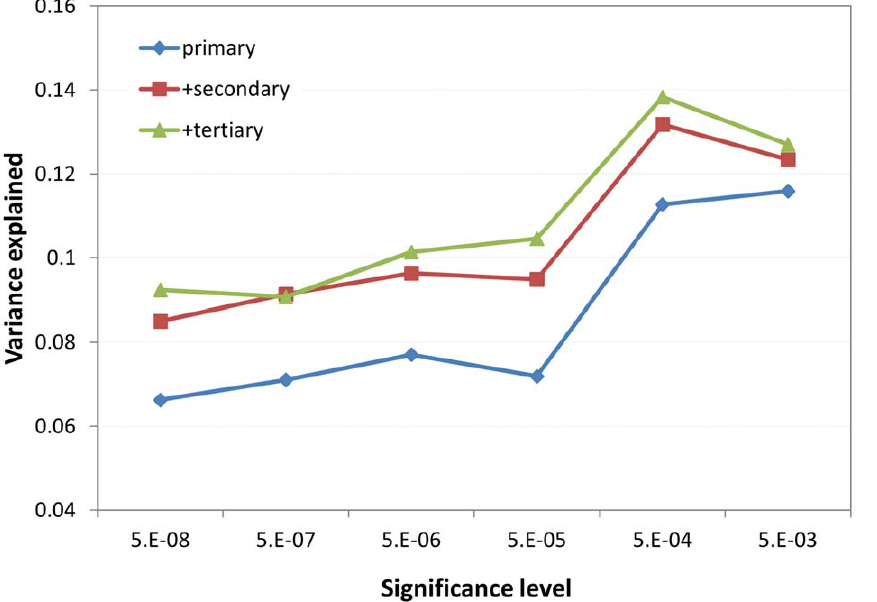
Figure 3. Additional fraction of variance explained could be obtained by including less significant SNPs and secondary/tertiary SNPs.